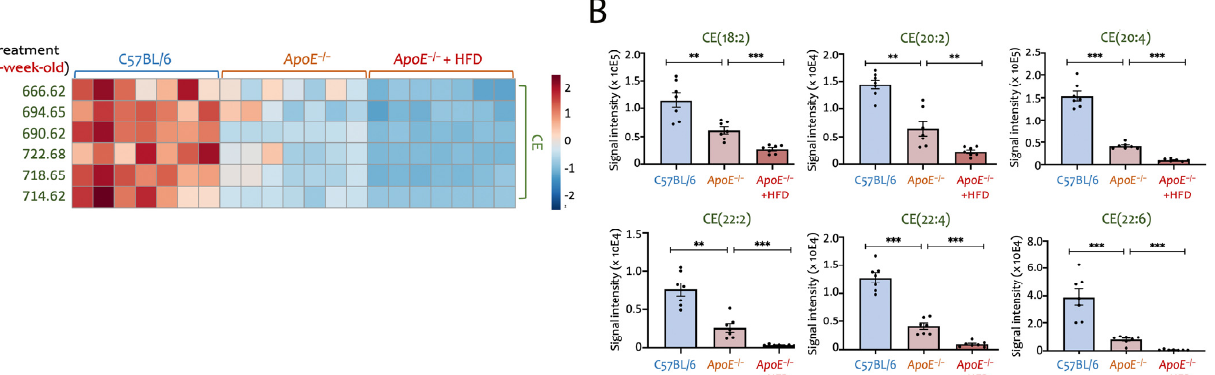
that compared to C57BL/6. After HFD treatment, the di ff erence could be more than ten times elevated in comparison to C57BL/6. Abbreviations: apoE − / − : apolipoprotein E knockout; HFD: high-fat